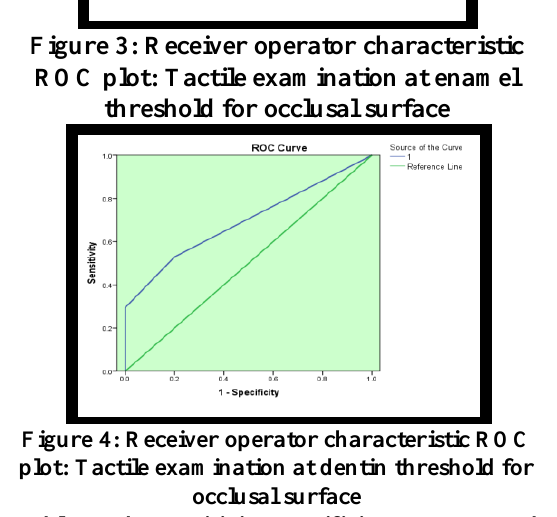
Figure 3: Receiver operator characteristic ROC plot: Tactile examination at enamel threshold for occlusal surface